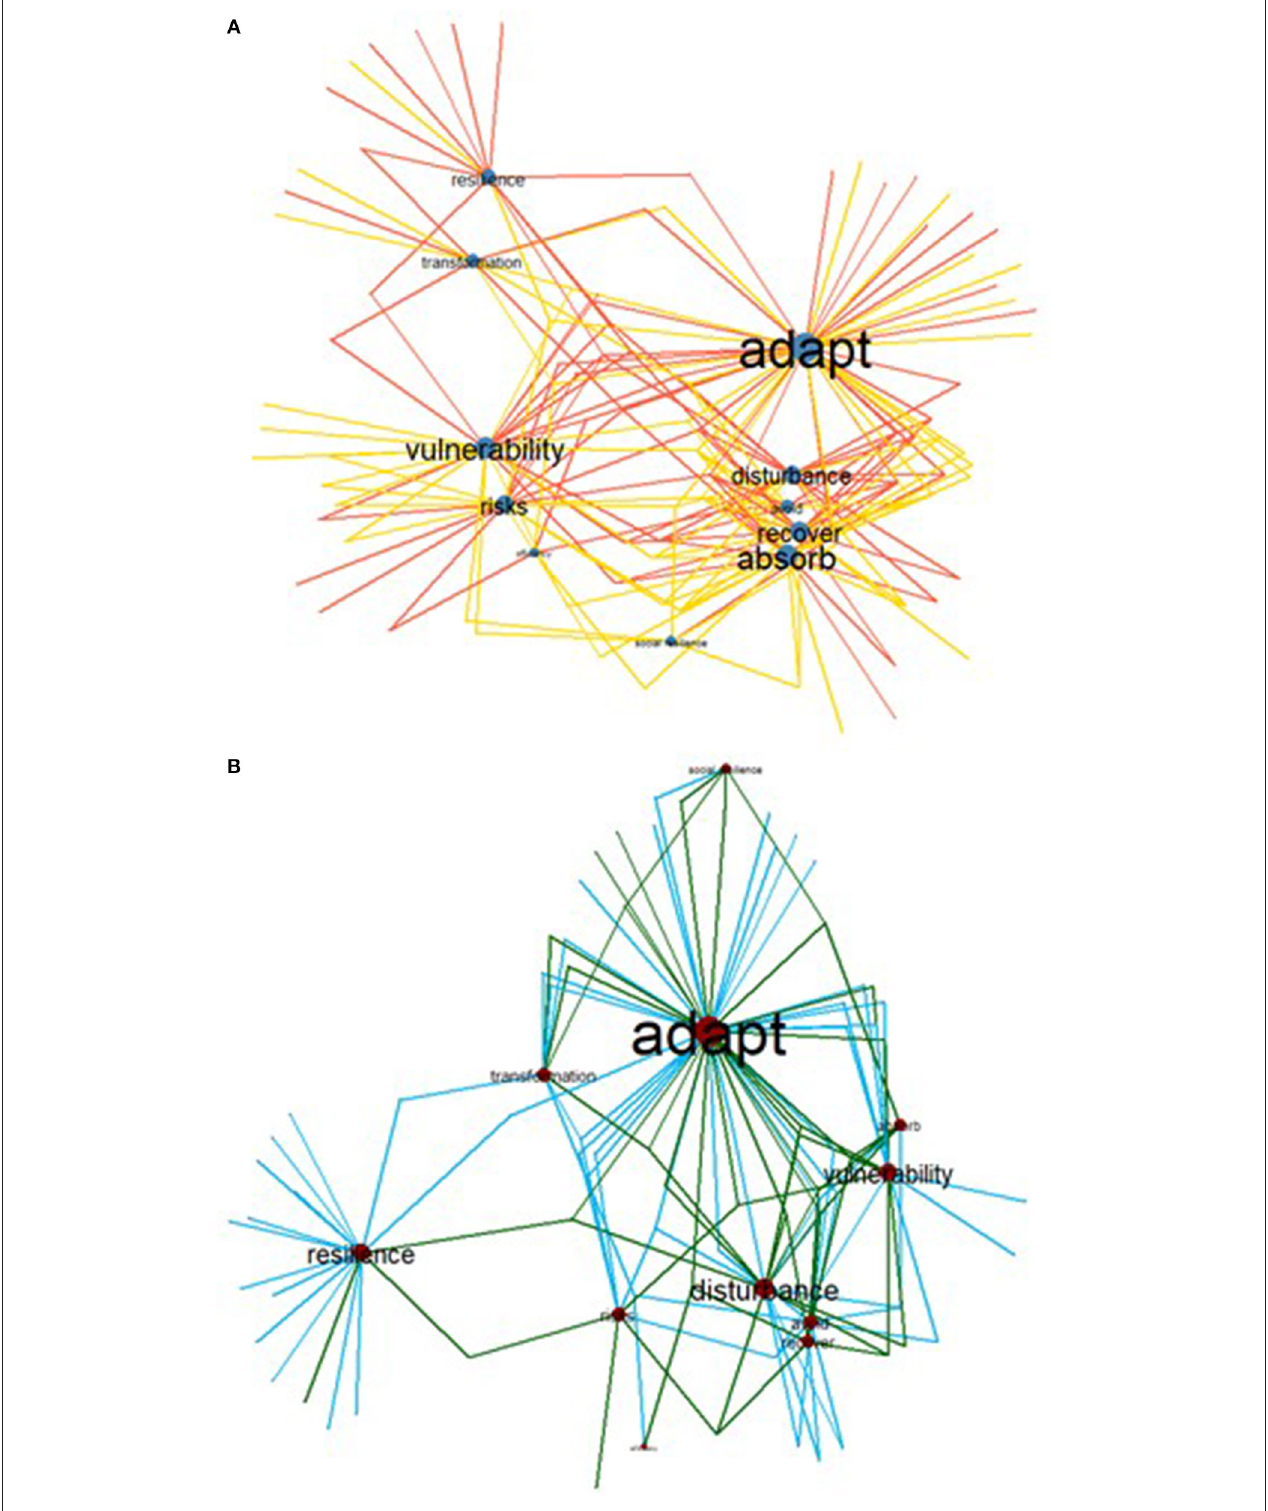
FIGURE 3 | Resilience definition codes used in (A) Southeast Asian projects/initiatives (red) and research studies (yellow), and (B) PICTS projects/initiatives (blue) and research studies (green). Chart shows degree centrality scores based on networks disaggregated by region.